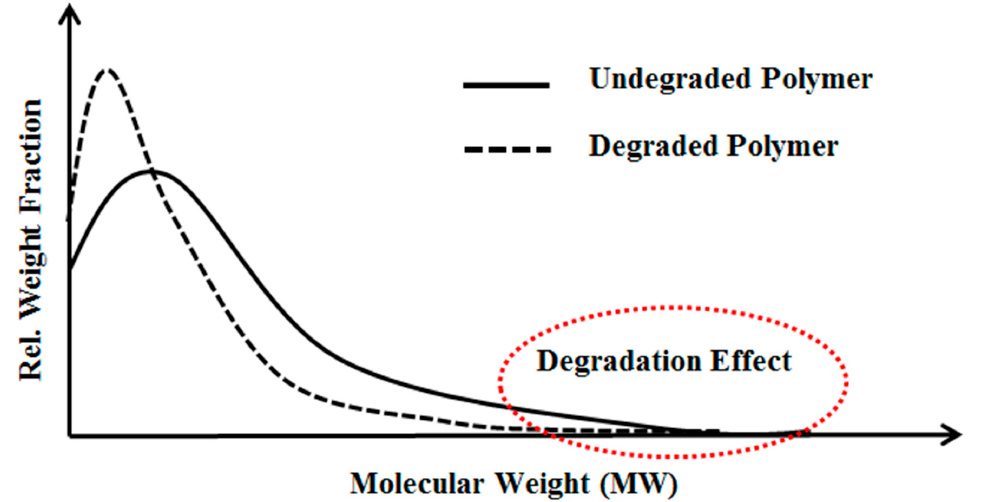
Figure 1. Schematic illustration of the effect of mechanical degradation on polymer molecular weight distribution (MWD) based on the observations reported by Seright, et al . [33]. The peak of the degraded solution shifts to a lower molecular weight. MWD was reduced for the degraded solution.